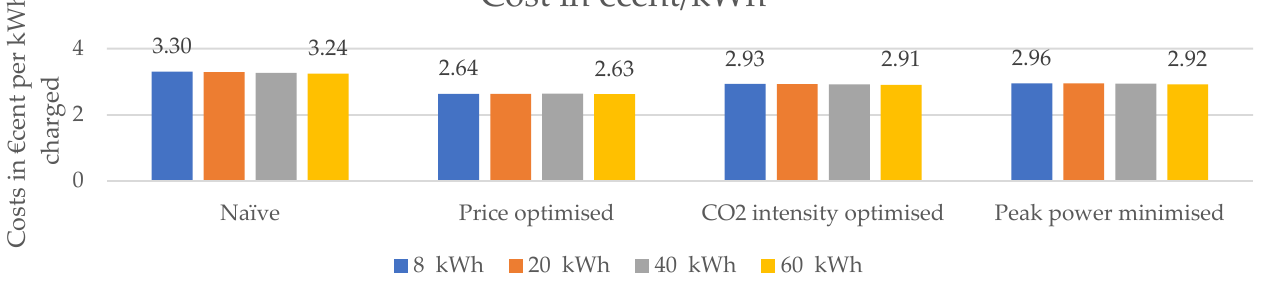
Figure 15. Costs in EURcent per kWh for the charged energy used assuming the energy recharged per charge event and charging strategies.